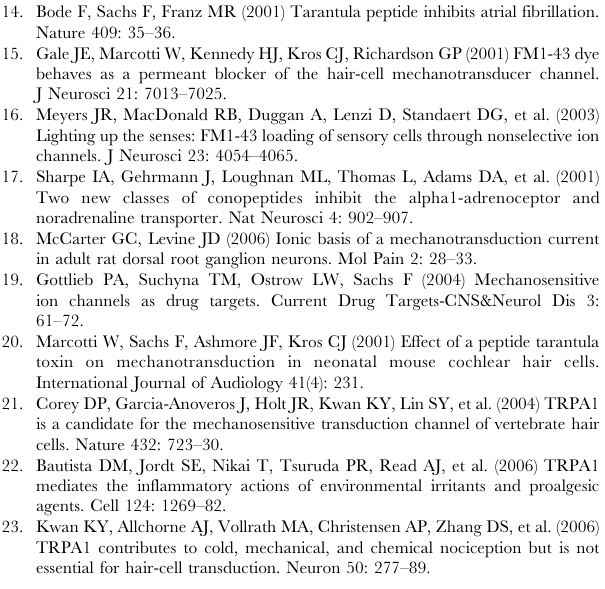
Figure S1 NMB-1 effects on TRPA1. Lack of effect of NMB-1 on mustard oil (MO)-evoked currents in TRPA1-transfected CHO-K1 cells. (A) Note that the current does not reactivate after wash of NMB-1 by MO, indicating that the exponential decay of the current is due to desensitization rather than block by NMB-1. (B) A mix of MO and NMB-1 does not prevent activation of TRPA1 current. (A) and (B) are from two different cells. In both [MO] = 100 m M and [NMB-1] = 2 m M. Experiments performed using an external solution containing 2mM Ca 2 + (n =4). Similar data were obtained using either a Ca 2 + -free external